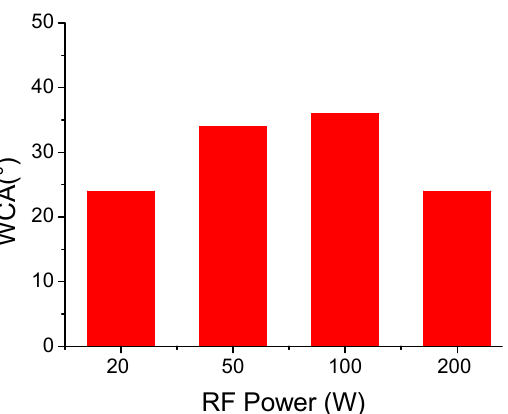
Figure 9. Static water contact angle of deposited films vs. plasma power.